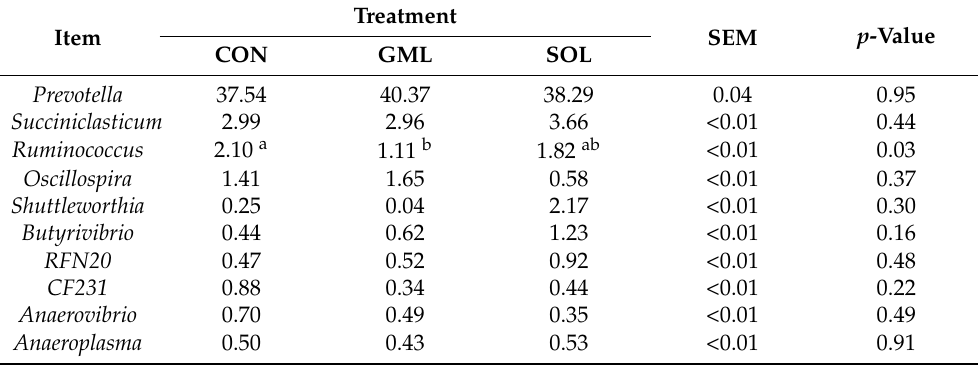
Table 6. Effects of monoglyceride laurate and Solider on the relative abundance of rumen microor- ganisms at the genus level